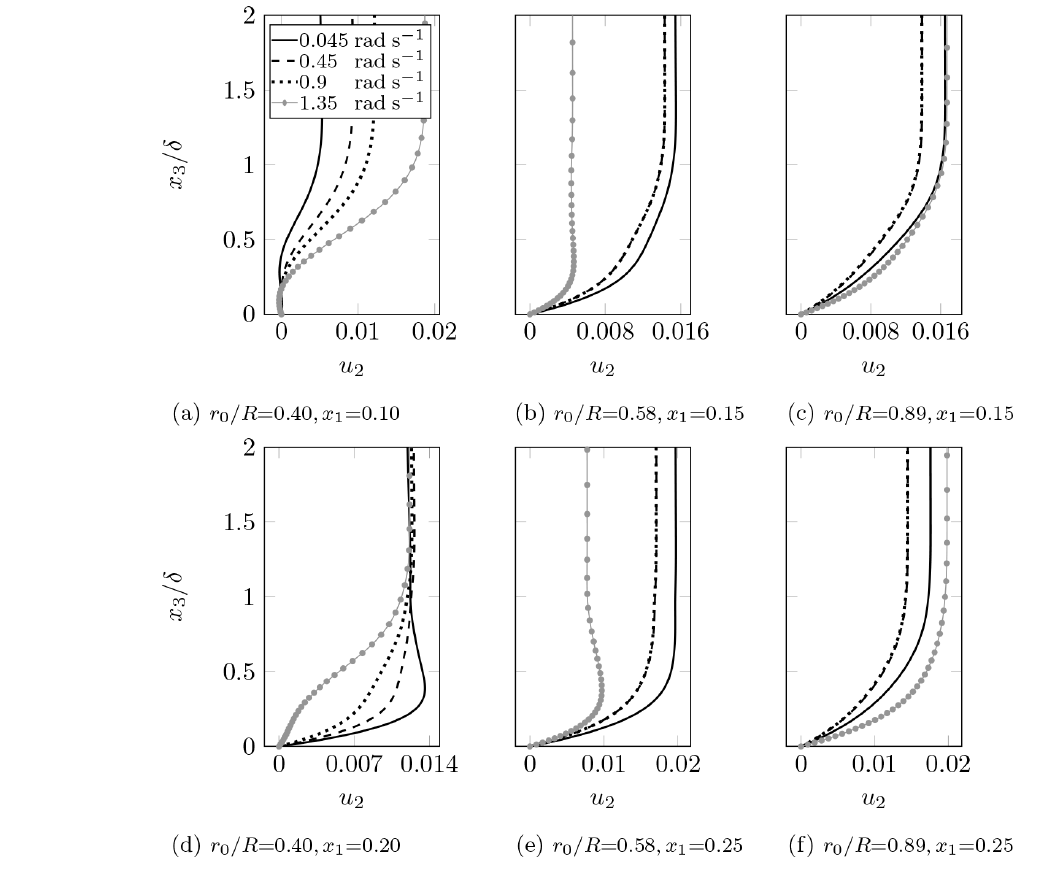
Figure 9. Spanwise velocity profiles for Geometry 2 for several rotation speeds.